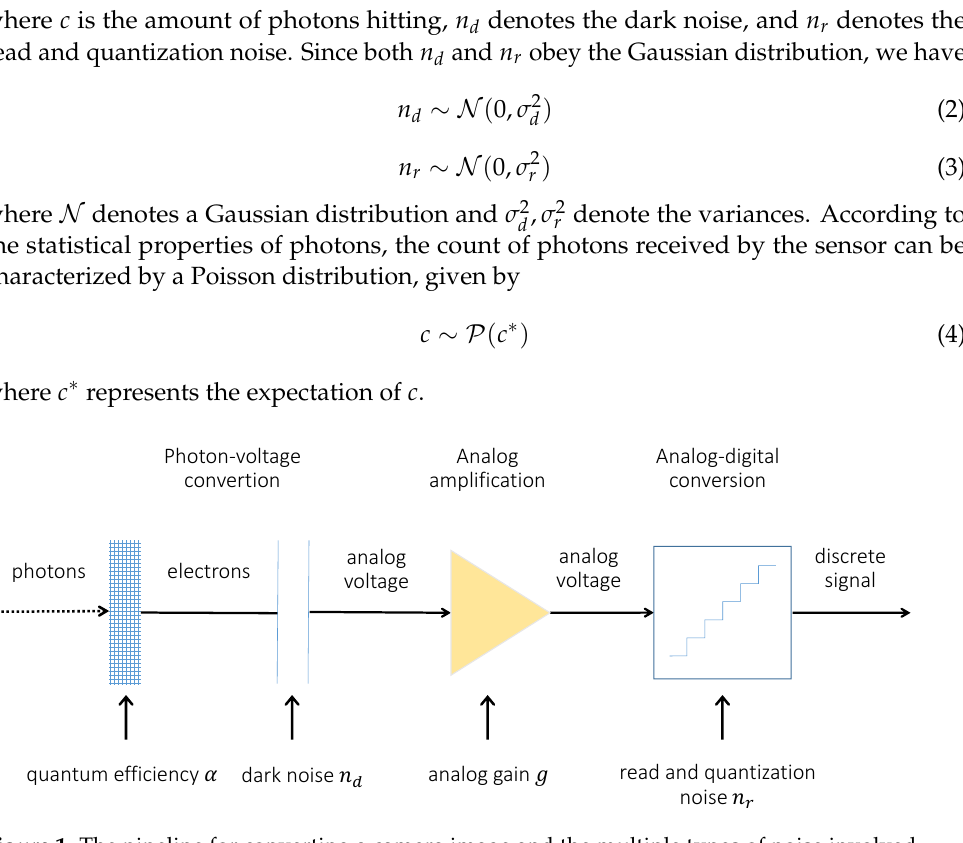
Figure 1. The pipeline for converting a camera image and the multiple types of noise